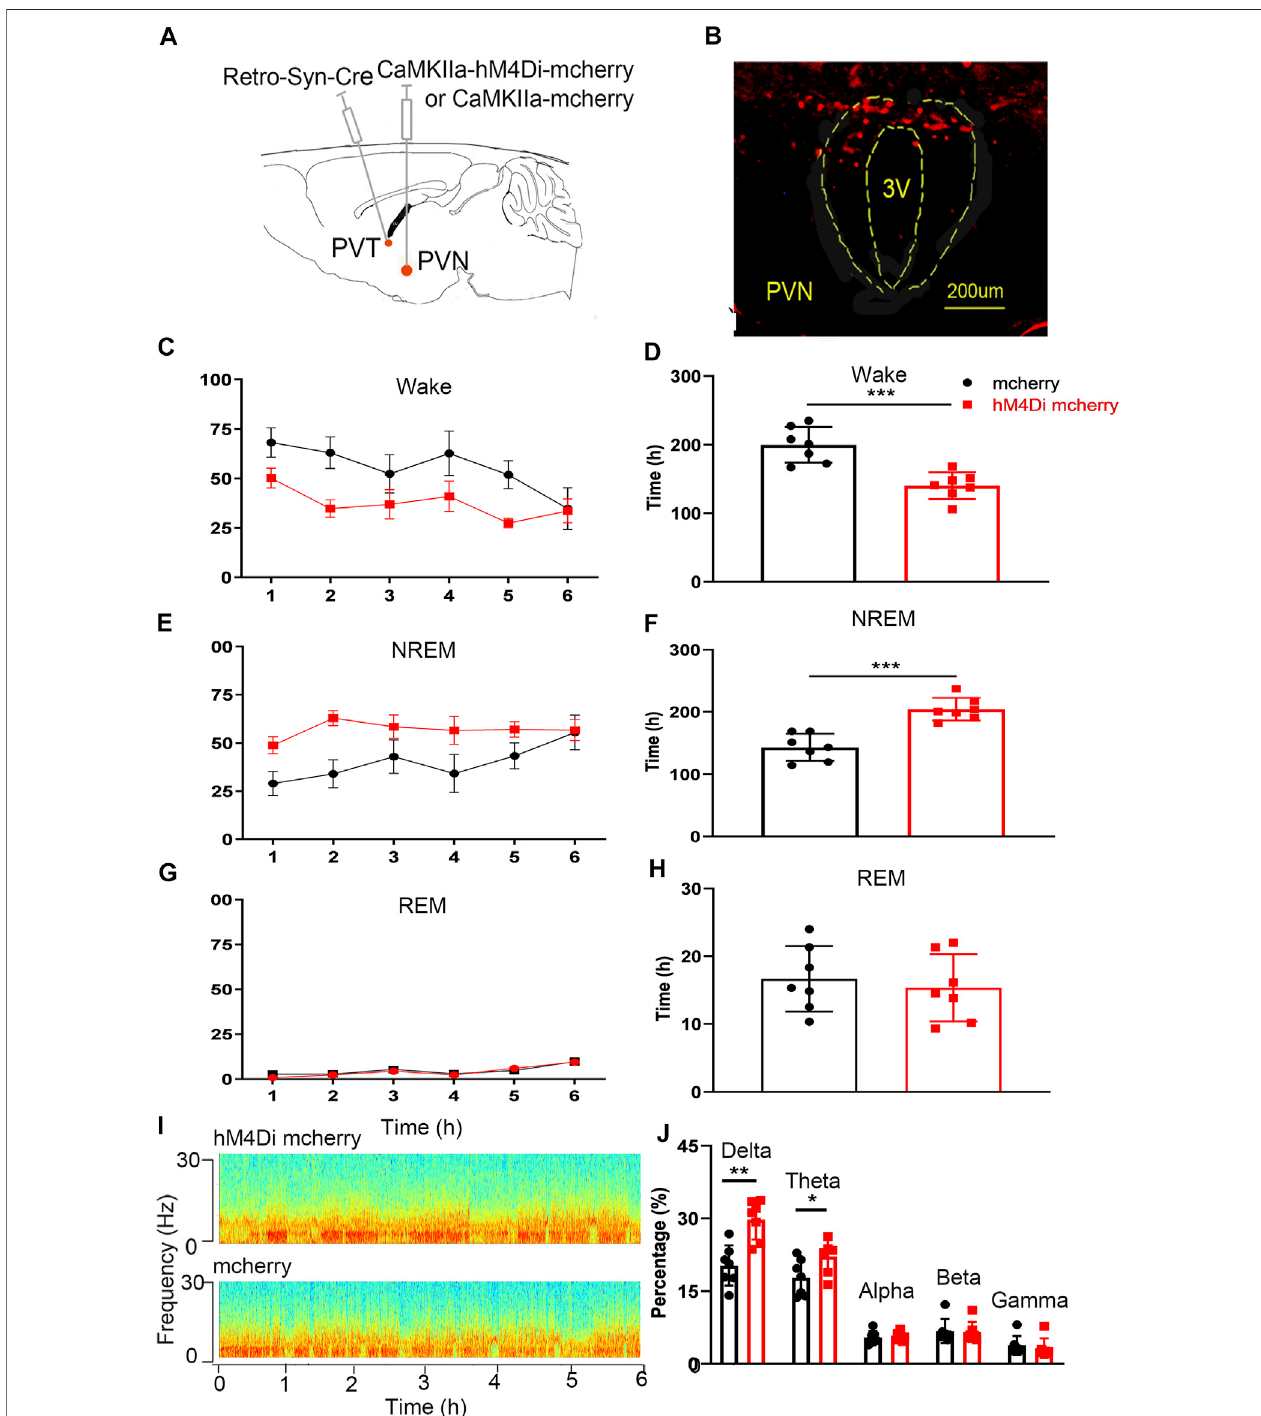
FIGURE 7 | Chemogenetic inhibition of the PVN-PVT neural circuit decreases wakefulness. (A) Experimental design of chemogenetic inhibition of the PVT- projecting PVN neurons. (B) Expression of hM4Di-mCherry in PVT-projecting PVN neurons. (C) The wake time percentages curve during 6 h after CNO injection in hM4Di-mCherry group and mCherry group, respectively. (D) Chemogenetic inhibition of the PVN-PVT neural circuit decreased the wake time. (E) The NREM time percentages curve during 6 h after CNO injection in hM4Di-mCherry group and mCherry group, respectively. (F) Chemogenetic inhibition of the PVN-PVT neural circuitincreasedtheNREM time. (G) TheREMtime percentagescurveduring 6 hafterCNO injection inboth groups. (F) Chemogeneticinhibition ofthePVN-PVTneural circuit did not affect the REM time. (I) Representative EEG power spectrum in hM4Di mcherry and mcherry group. (J) The percentage of delta in EEG power increased after activation of the PVN-PVT neural circuit (* p < .05, ** p < .01, *** p < .001, n = 7/group. Error bars denote SEM. Unpaired two-tailed Student ’ s t -test).